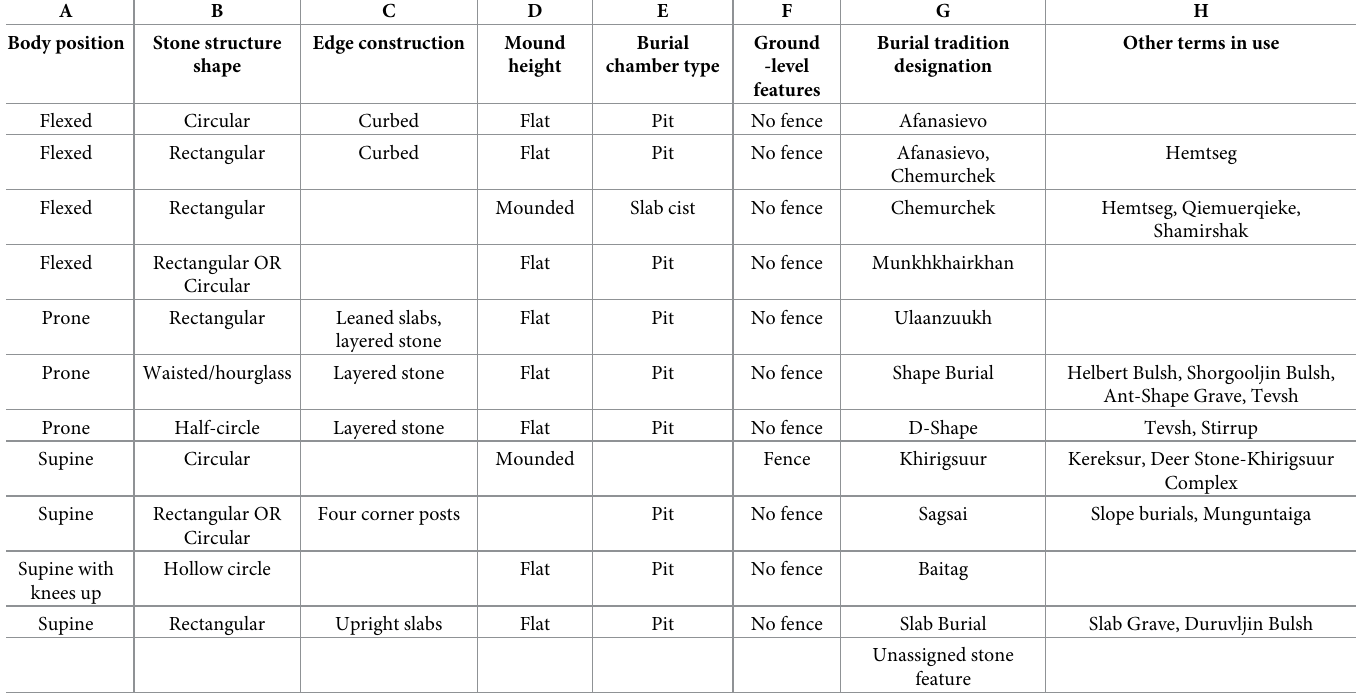
Table 1. Burial traits used in classification scheme. For detailed description of architectural traits see Eregzen 2016, Wright 2007, Wright 2014, Kovalev and Erdenebaa- tar 2009, Fitzhugh